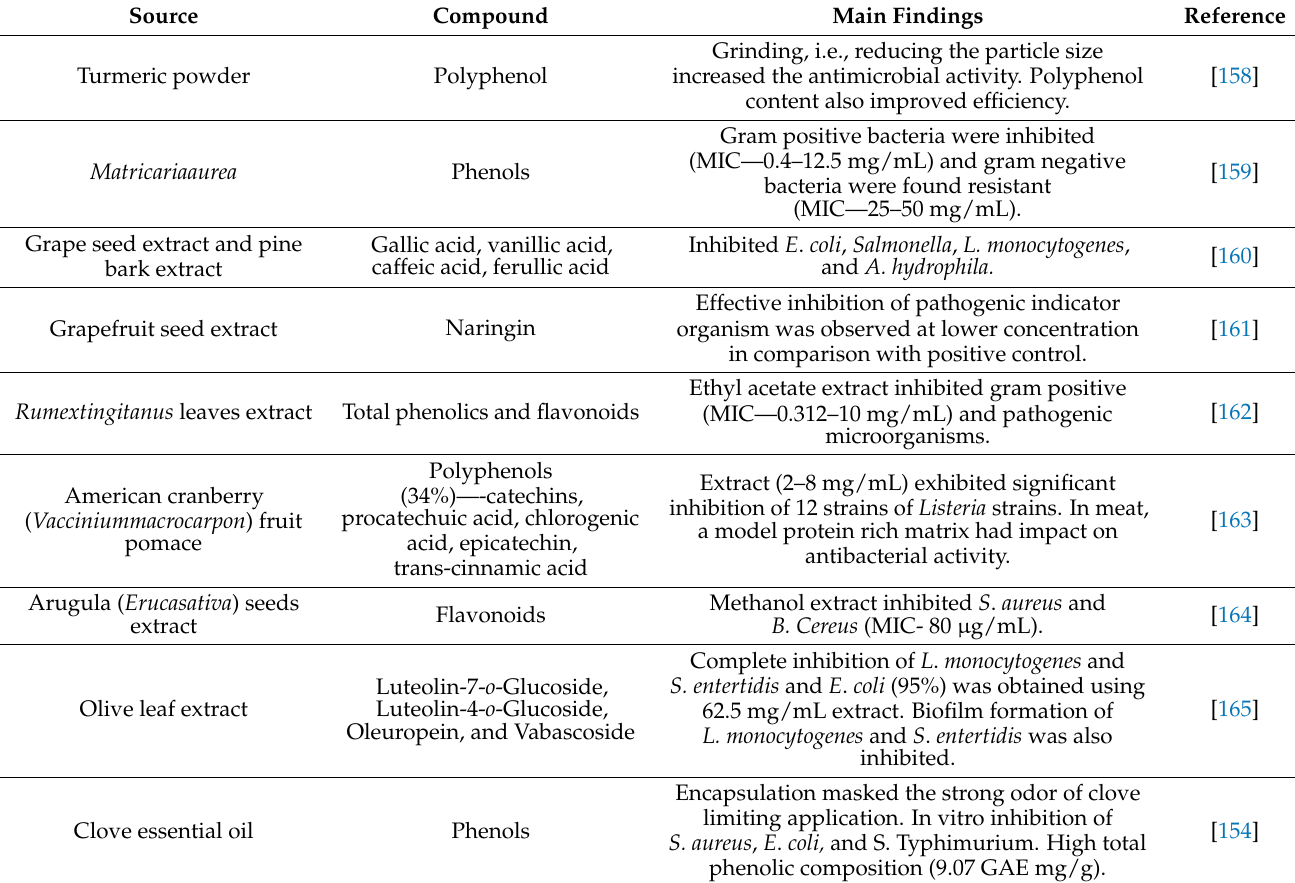
Table 4. Antimicrobial activity of phenolic